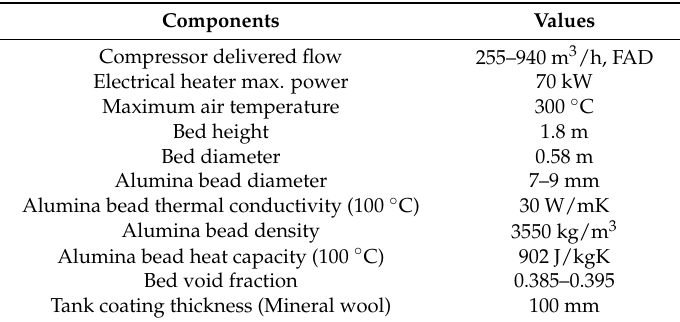
Table 1. Technical data of rig